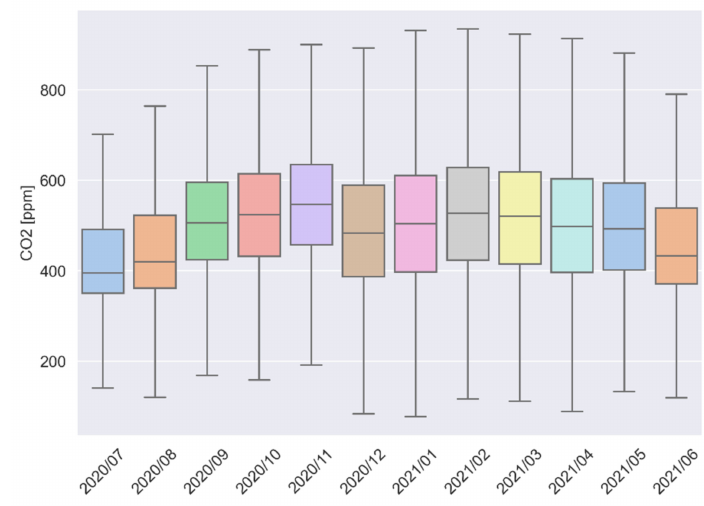
Figure 30. Monthly CO 2 concentration from all apartments.